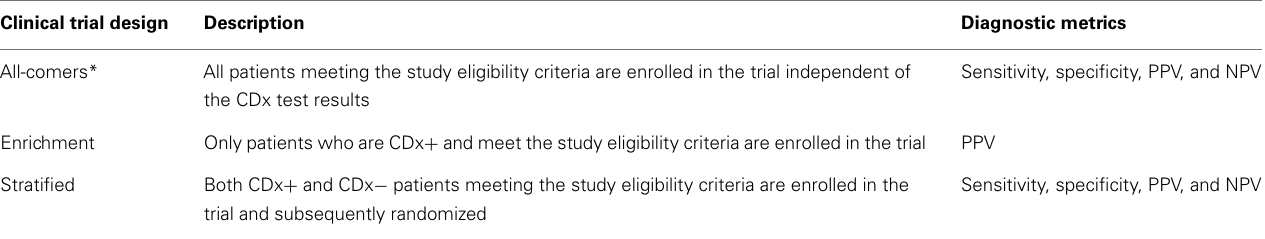
Table 1 | Overview of the main clinical trial designs that have been proposed for the parallel development of drugs and diagnostics .The last column in the table lists the diagnostic metrics that can be calculated based on the given clinical trial design. CDx + , test positive patients; CDx − , test negative patients; PPV, positive predictive value; NPV, negative predictive